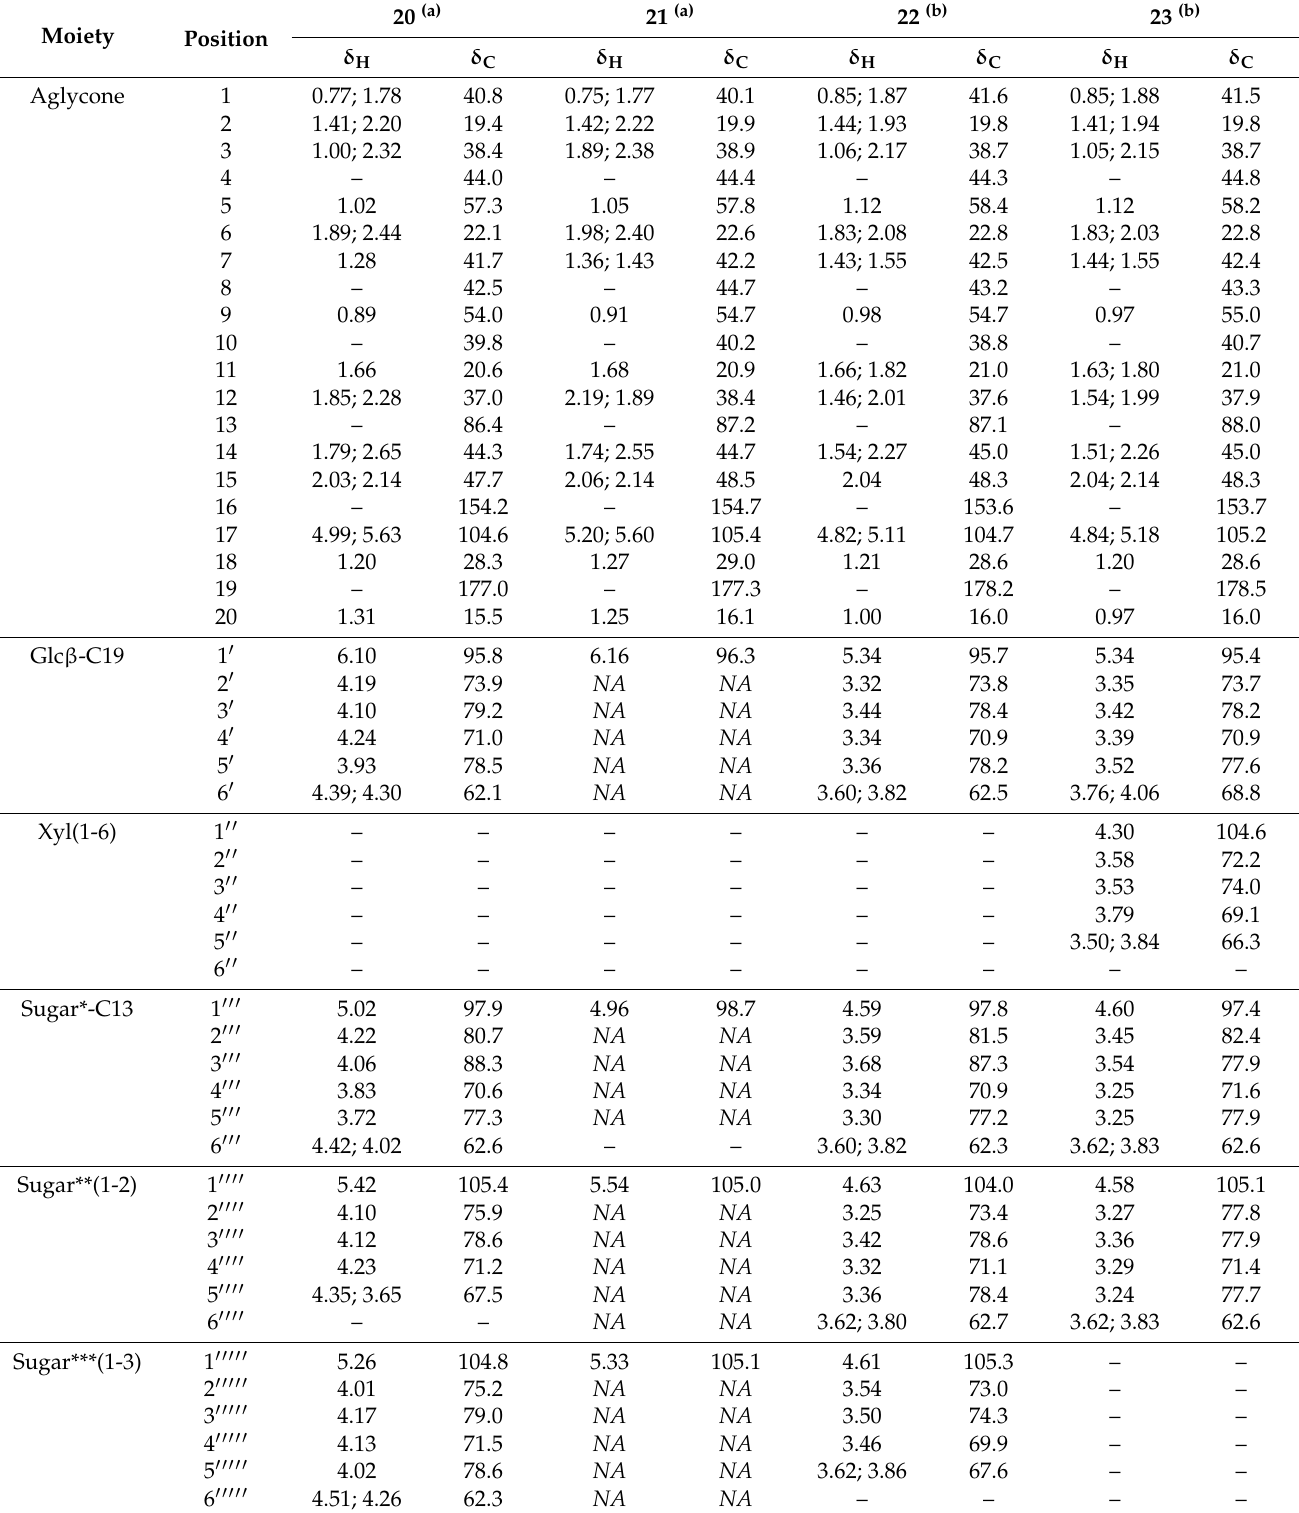
Table 7. 1 H and 13 C chemical shifts of the compounds 20 – 23